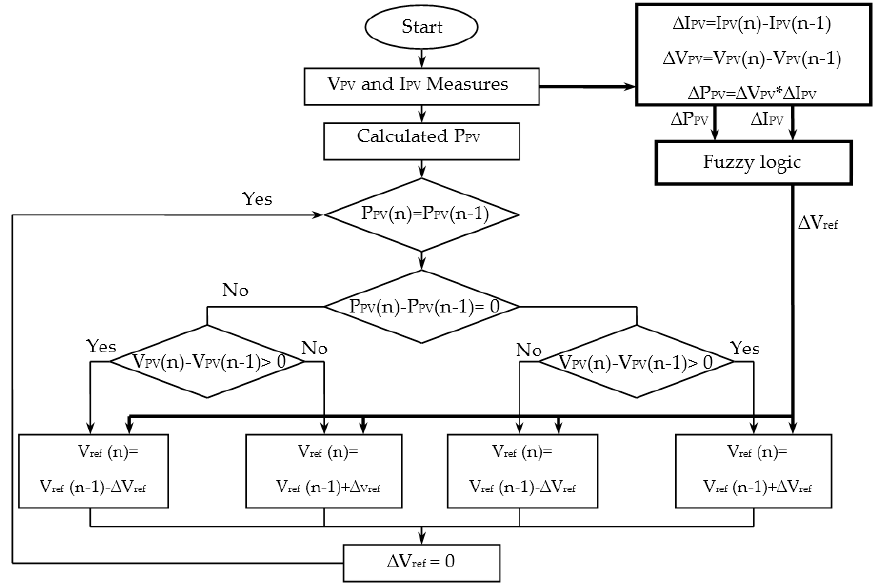
Figure 3. Flowchart of the modified perturb and observe (P&O) algorithm.